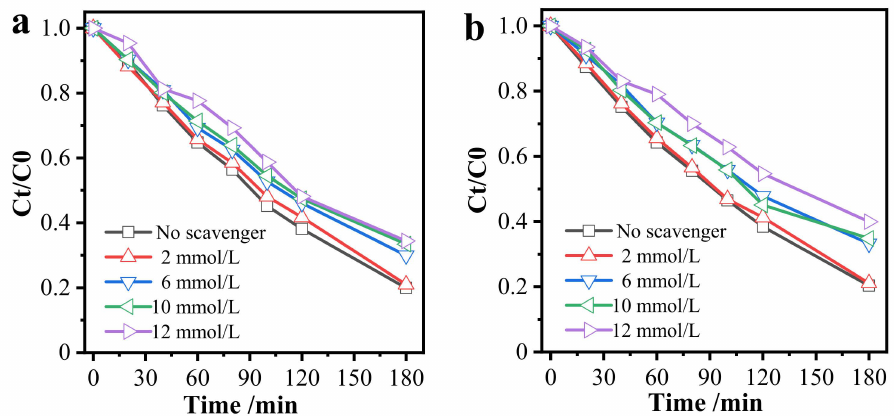
Figure 9. Effect of TCN-T 550 for photocatalytic of AAF degradation with different concentration quenching agents: ( a ) ammonium oxalate, ( b )